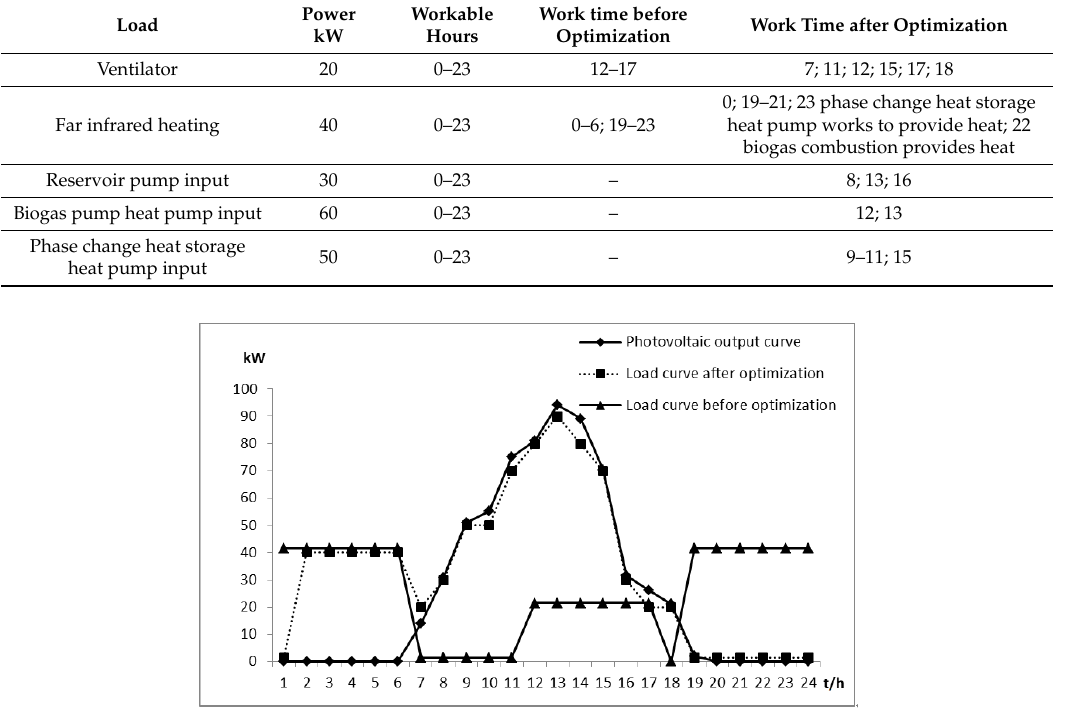
Figure 11. Comparison curve of load before and after optimization on a cloudy winter day after a rainy day.